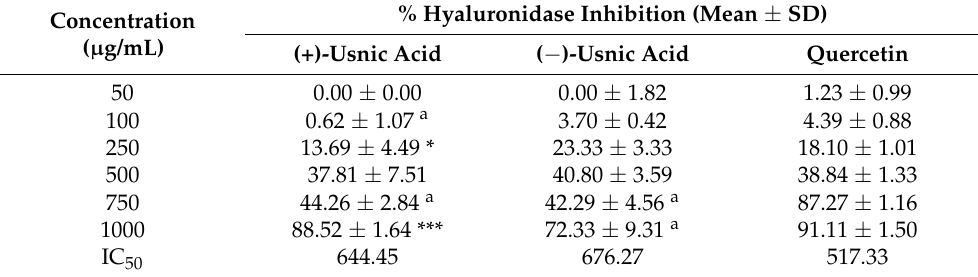
Table 3. Anti-hyaluronidase activity of (+)- and ( − )-usnic acid. Concentration ( µ